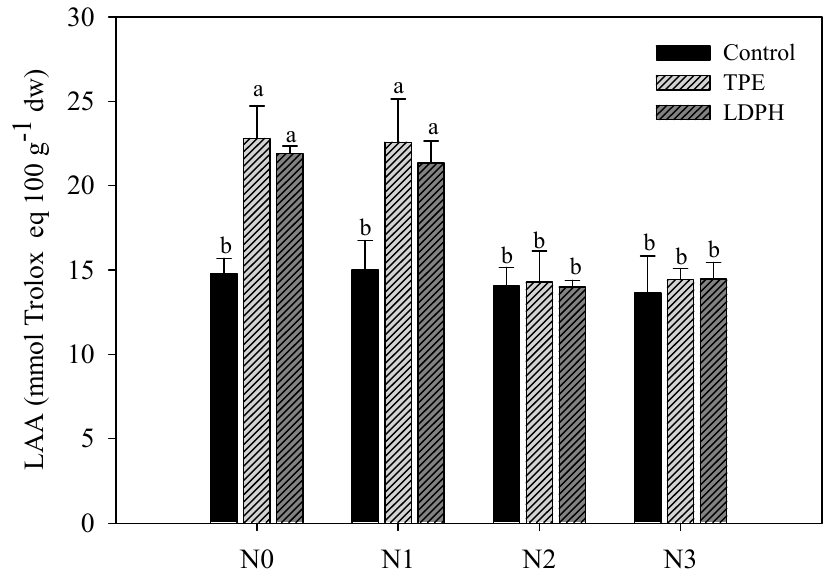
Figure 1. Lipophilic antioxidant activity (LAA) in relation to N fertilization rates (N0 = 0, N1 = 60, N2 = 80, and N3 = 100 kg ha –1 ) and biostimulant application (Control, tropical plant extract (TPE): Auxym and legume-derived protein hydrolysate (LDPH): Trainer). Different letters indicate significant differences at p ≤ 0.05.